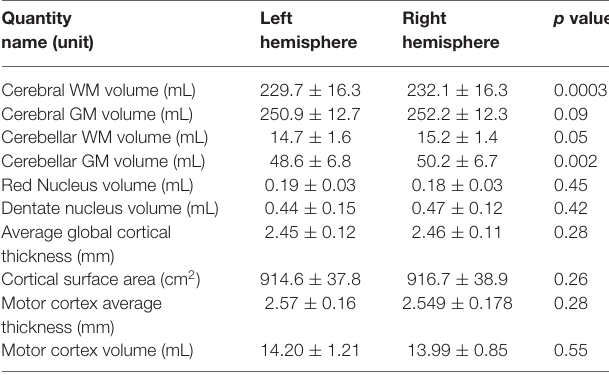
TABLE 3 | Group mean and standard deviation values of cerebral and cerebellar gray (GM) and white (WM) matter volumes, red and dentate nuclei volumes, average cortical thickness and cortical surface area of ten subjects are presented in this table . Quantity Left